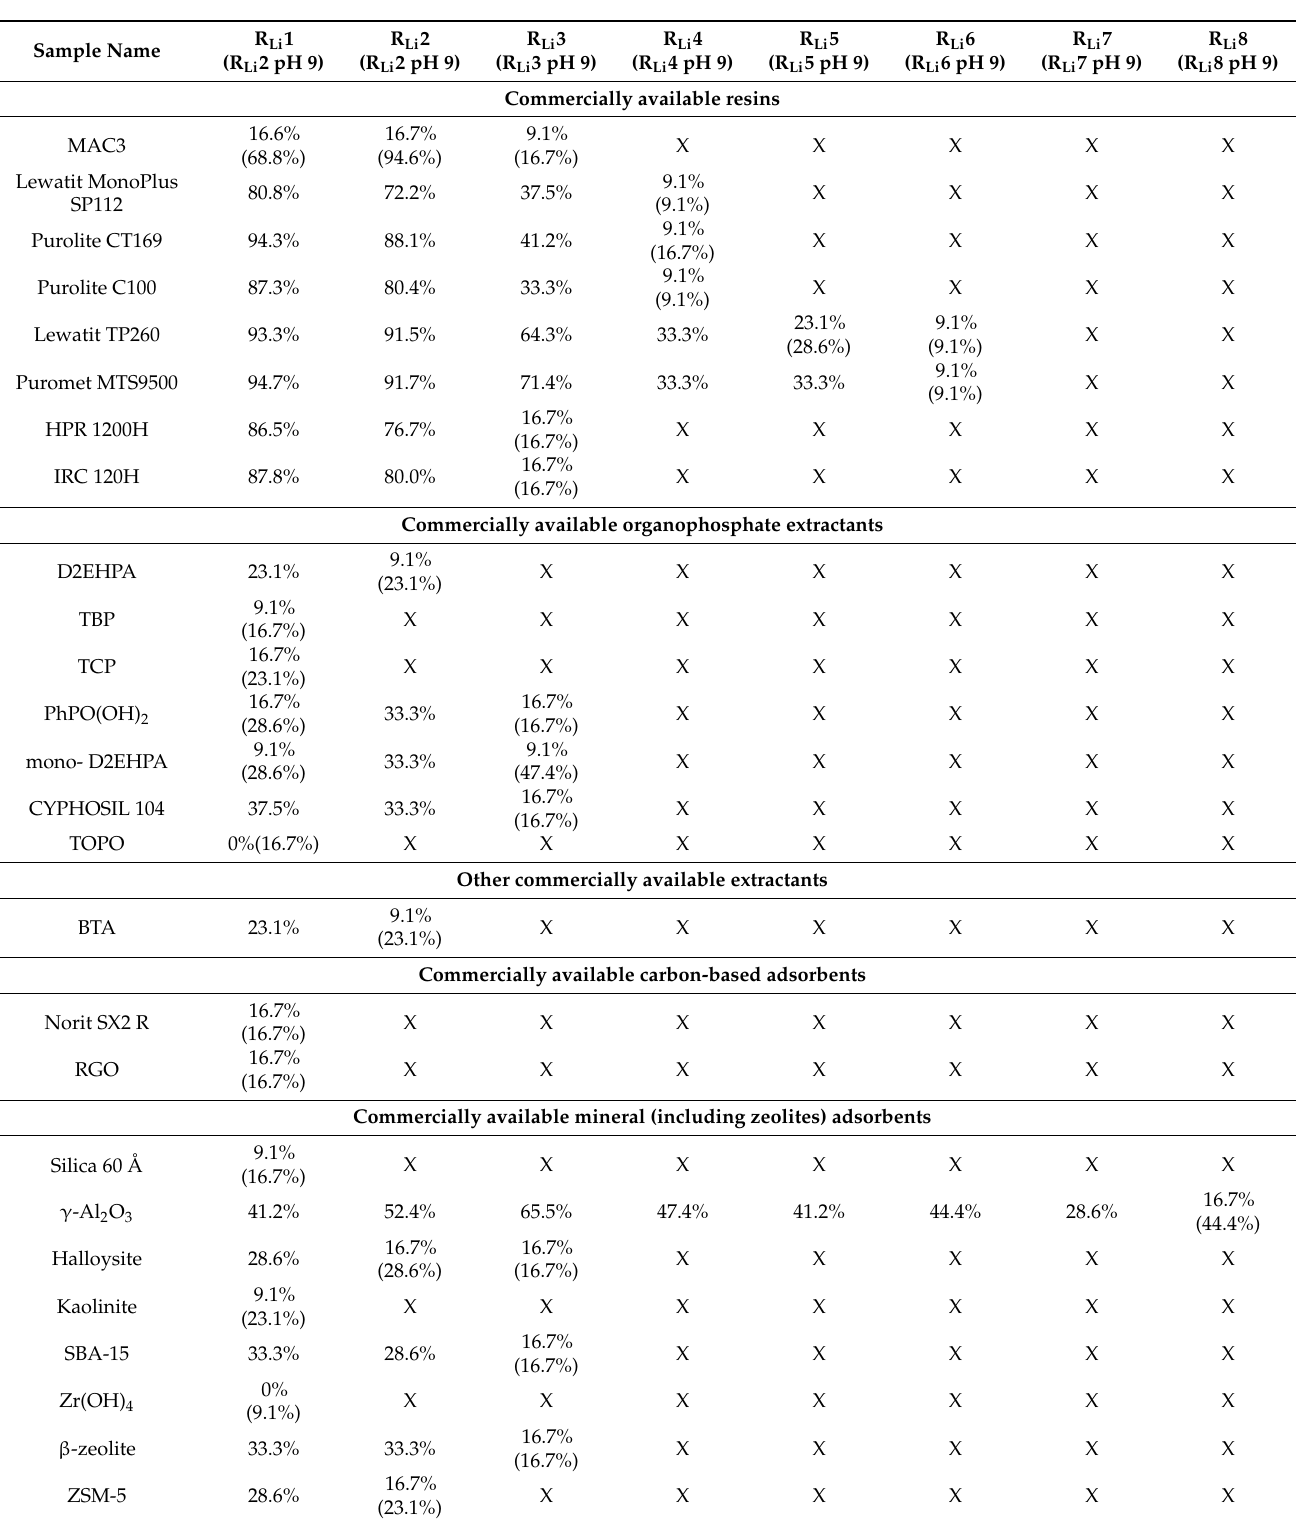
Table A2. Influence of brine composition on the recovery of lithium ions (R Li )—results from a multi-stage screening